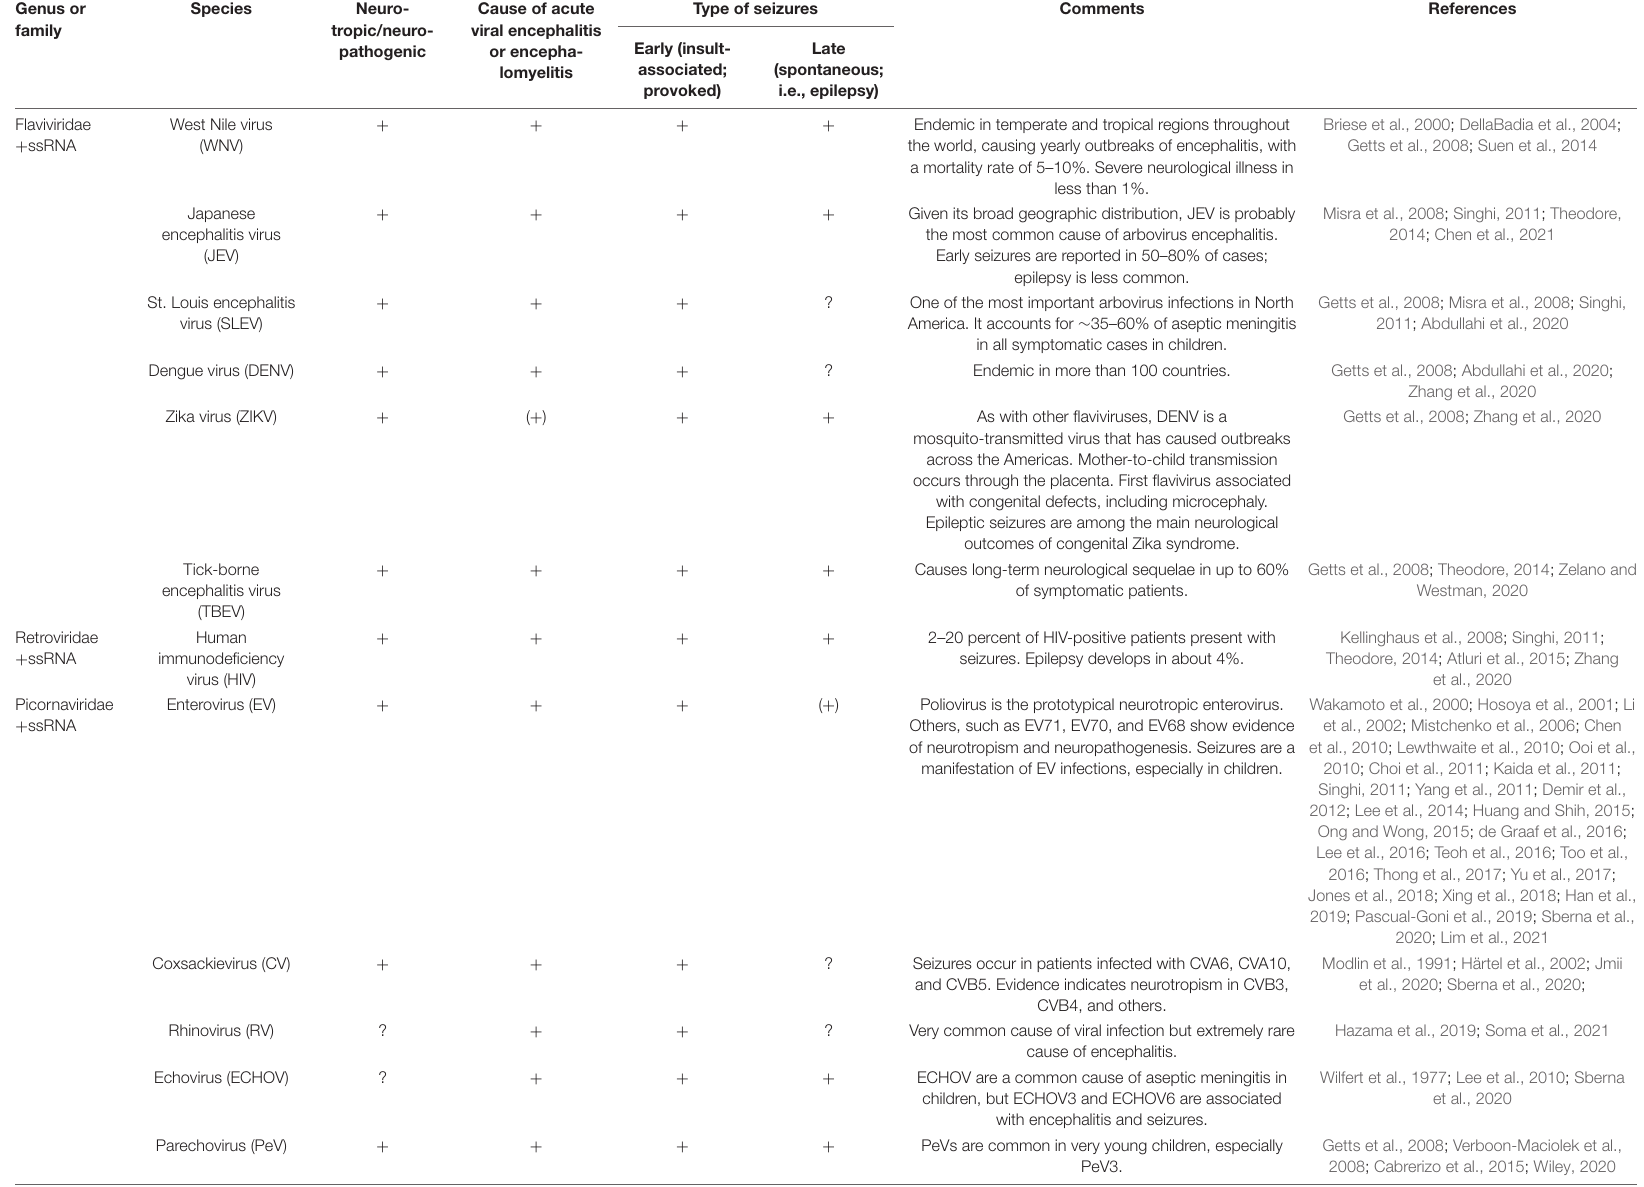
TABLE 1 | Common viruses associated with seizures and epilepsy in